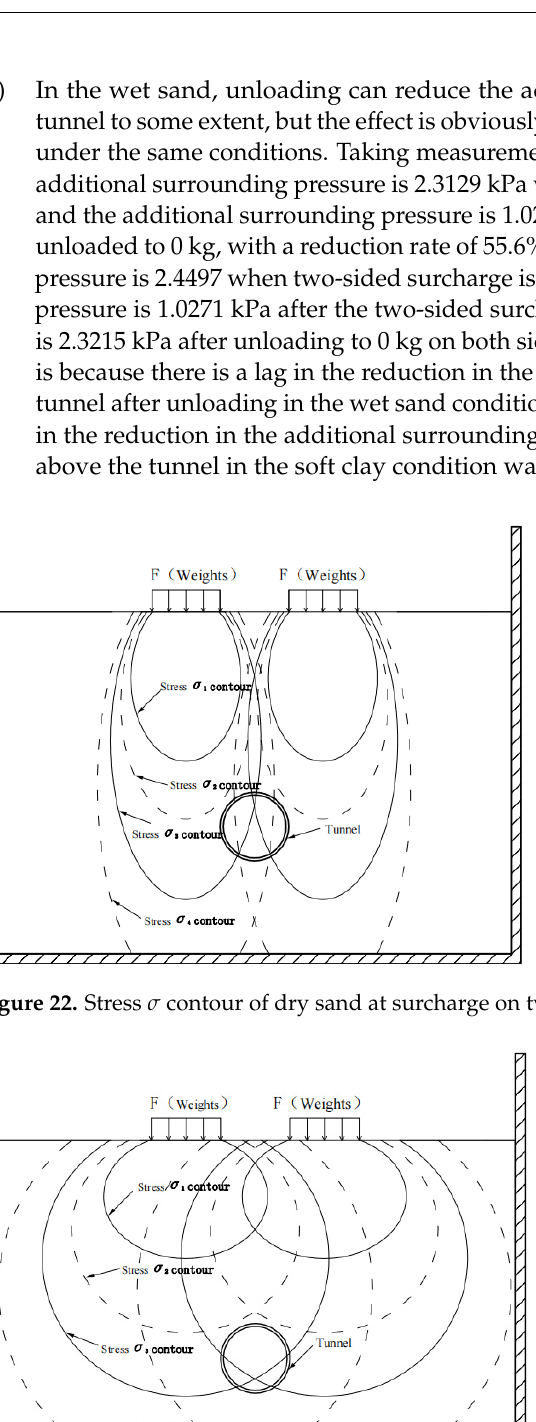
Figure 23. Stress σ contour of wet sand at surcharge on two